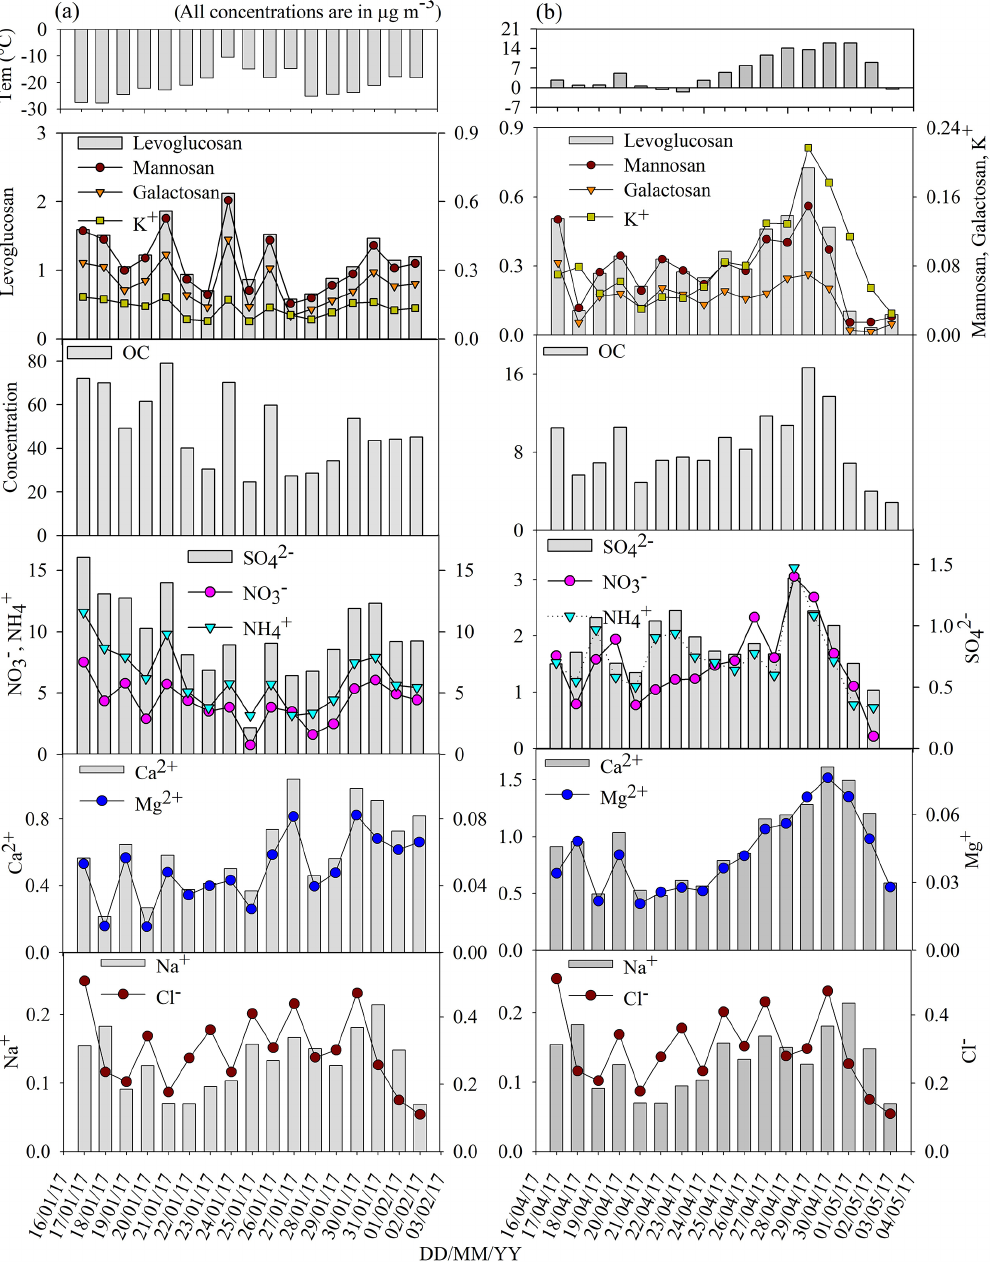
Figure 2. Daily variations in atmospheric concentrations (µgm − 3 ) of chemical species in Ulaanbaatar during winter (a) and spring (b) of